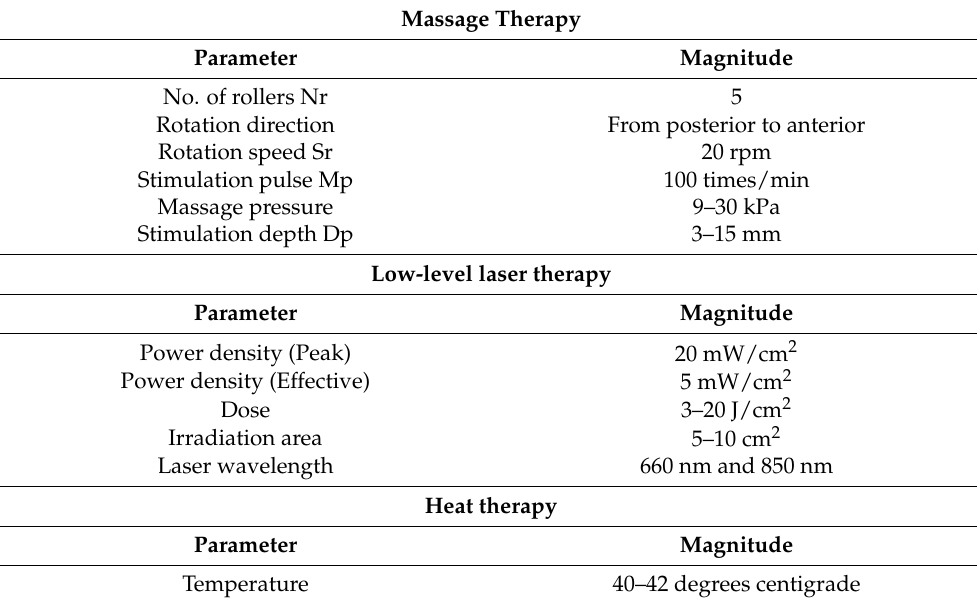
Table 2. Parameters of deep tissue stimulation CUHK-OA-M2